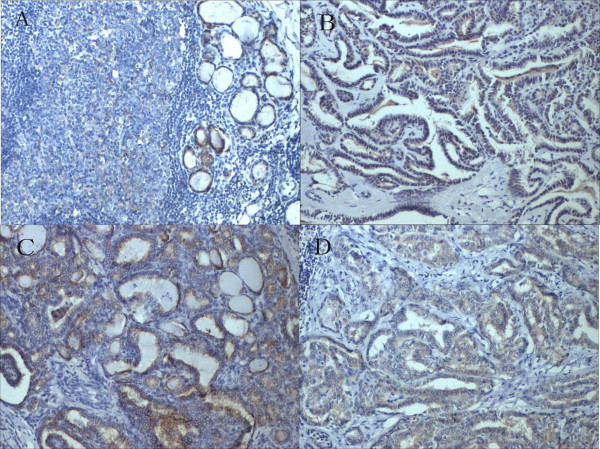
ALDH1A1 expression by immunohistochemical staining. (A) Normal thyroid tissue showed low expression of ALDH1A1. (B) PTC case demonstrated high expression of ALDH1A1 (×200). (C) High expression of ALDH1A1 was detected in a PTC case with extrathyroid invasion (×200). (D) High expression of ALDH1A1 was detected in a PTC case with lymph node metastasis (×200).